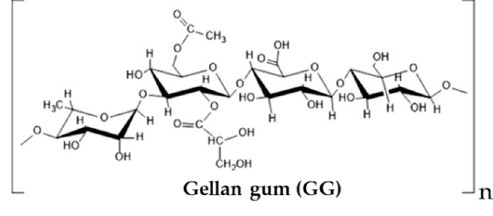
Figure 14. The structure of gellan gum.